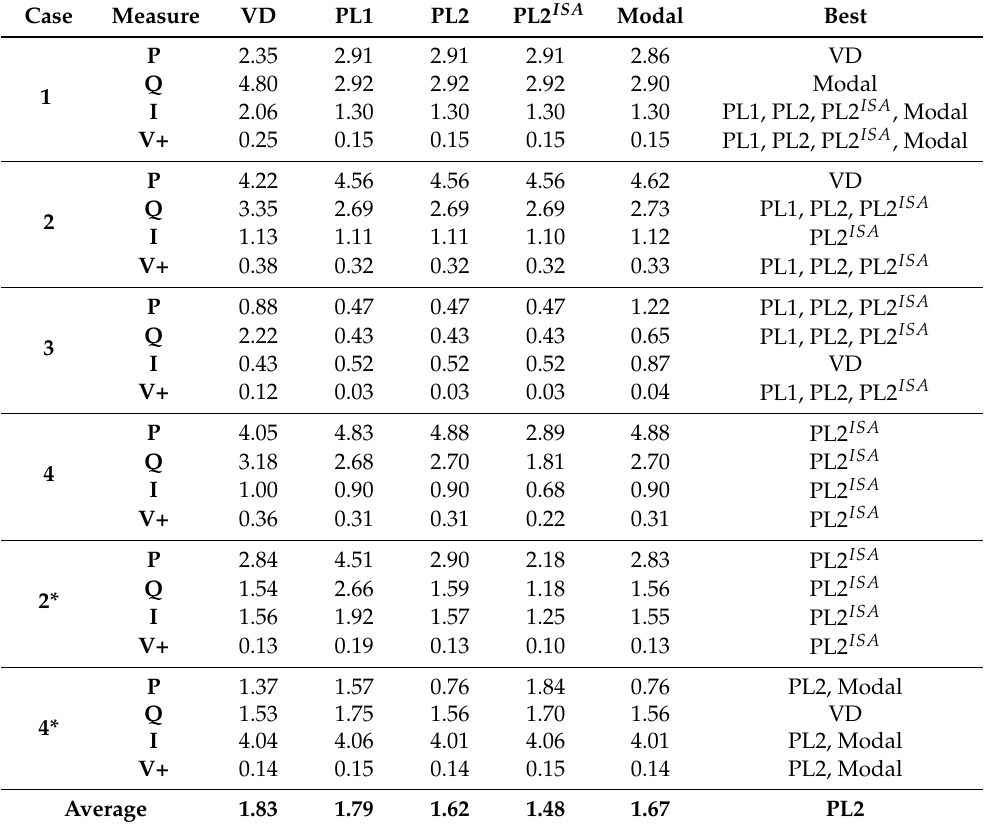
Table 5. RMS errors of measurements